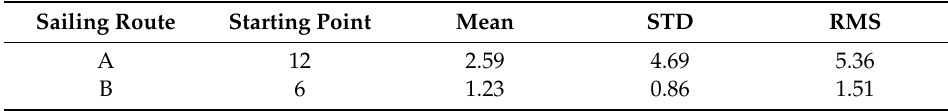
Table 2. Location accuracy of gravity matching for two sailing routes in different characteristic regions (unit: n mile).